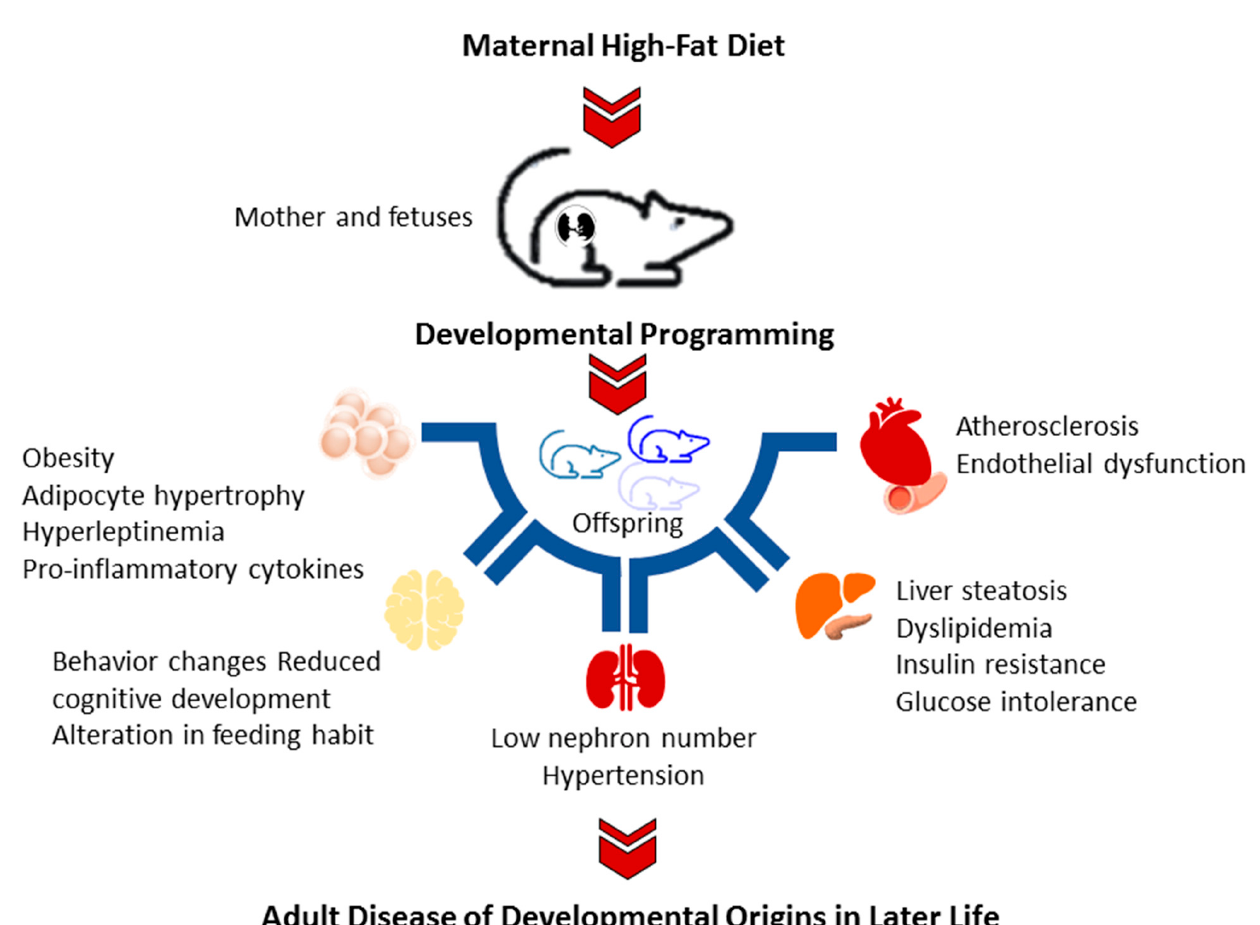
Figure 1. Schematic diagram summarizing the adverse offspring outcomes related to maternal high-fat diet.